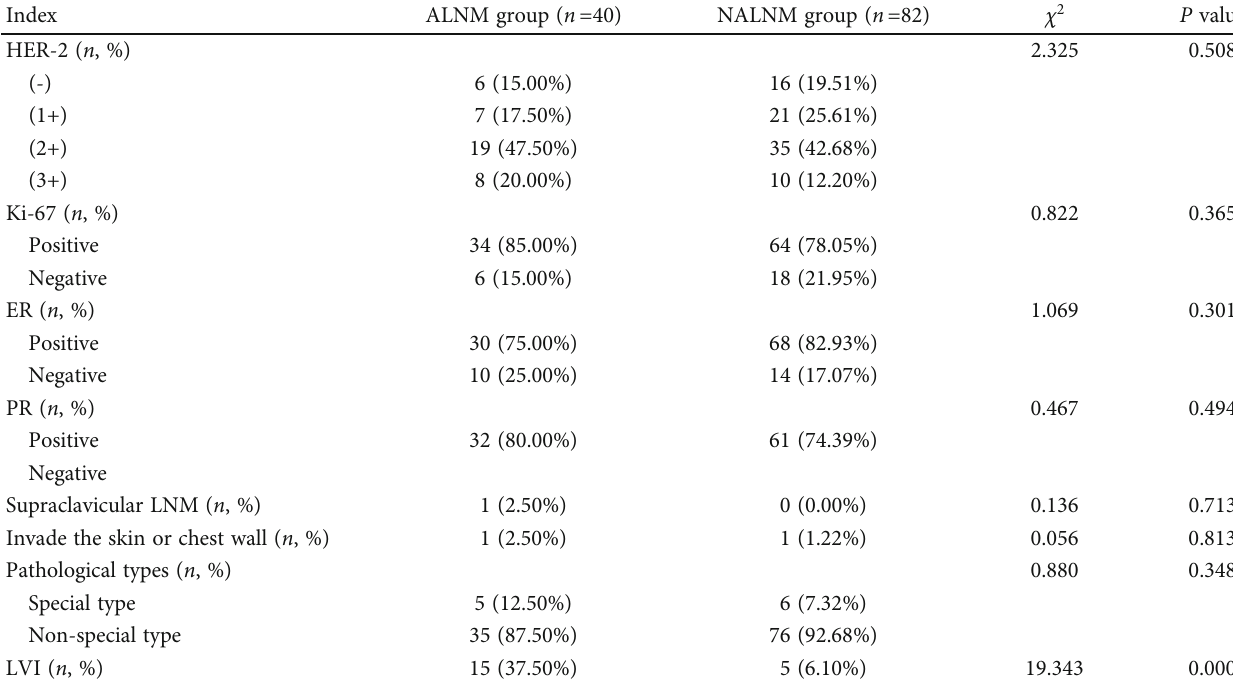
Table 4: Comparison of pathological features between two groups [cases, (%)].